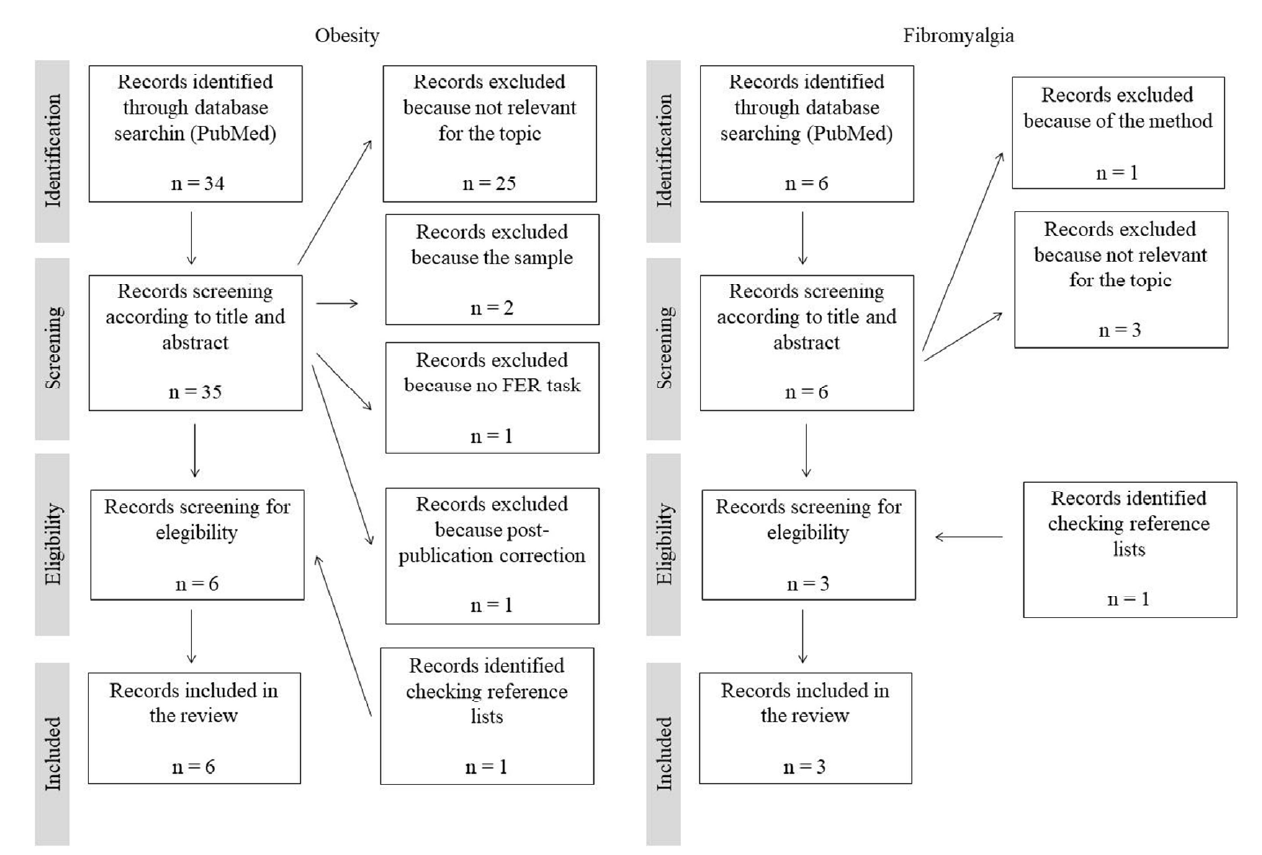
Figure 1. Flow diagram relative to the process of records